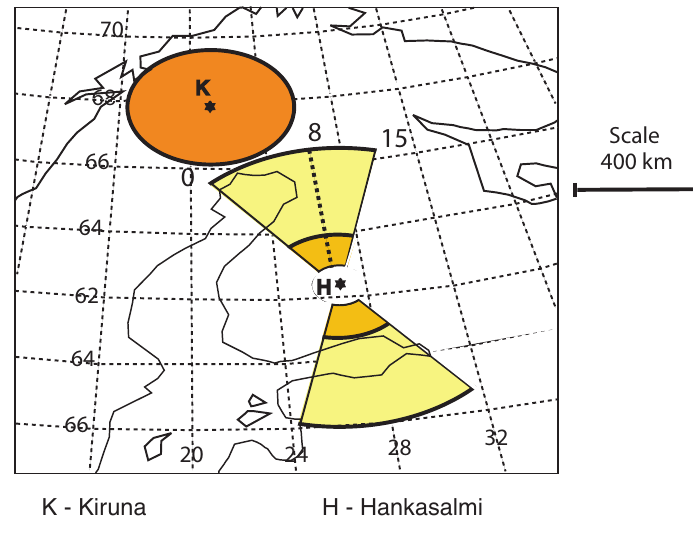
Fig. 2. Map of Northern Scandinavia with the locations of the Esrange VHF and SuperDARN Finland radars de- noted by a K and an H, respectively. The effective areas of meteor cover- age are shaded. At Hankasalmi, the outer shaded regions are observed by the common scanning mode, while both the inner and outer shaded regions are covered by a dedicated high resolution meteor